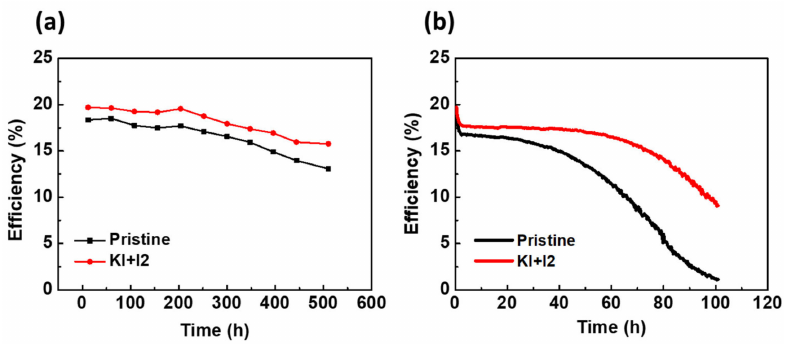
Figure 8. The stability of PSCs without encapsulation at 25 ◦ C and ~35 RH%: ( a ) during at-rest stability (dark storage) and ( b ) during continuous light soaking under 1 sun.